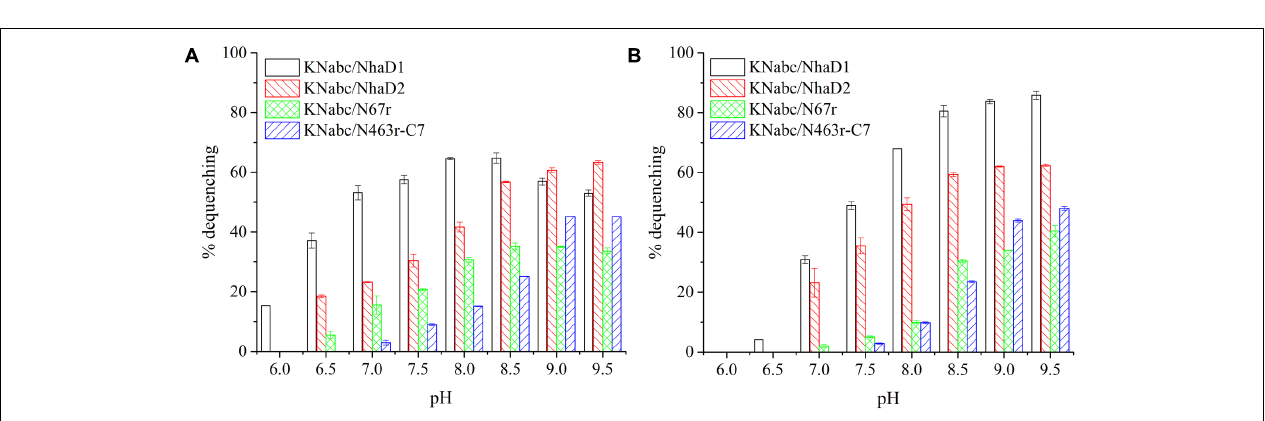
FIGURE 3 | Fluorescence-based antiport activities of NhaD1 chimerical proteins in sub-bacterial vesicles. (A) Transport activities of NhaD1 chimeric proteins with a supplementation of 10 mM NaCl at various pHs. (B) Transport activities of NhaD1 chimeric proteins with a supplementation of 10 mM LiCl at various pHs.